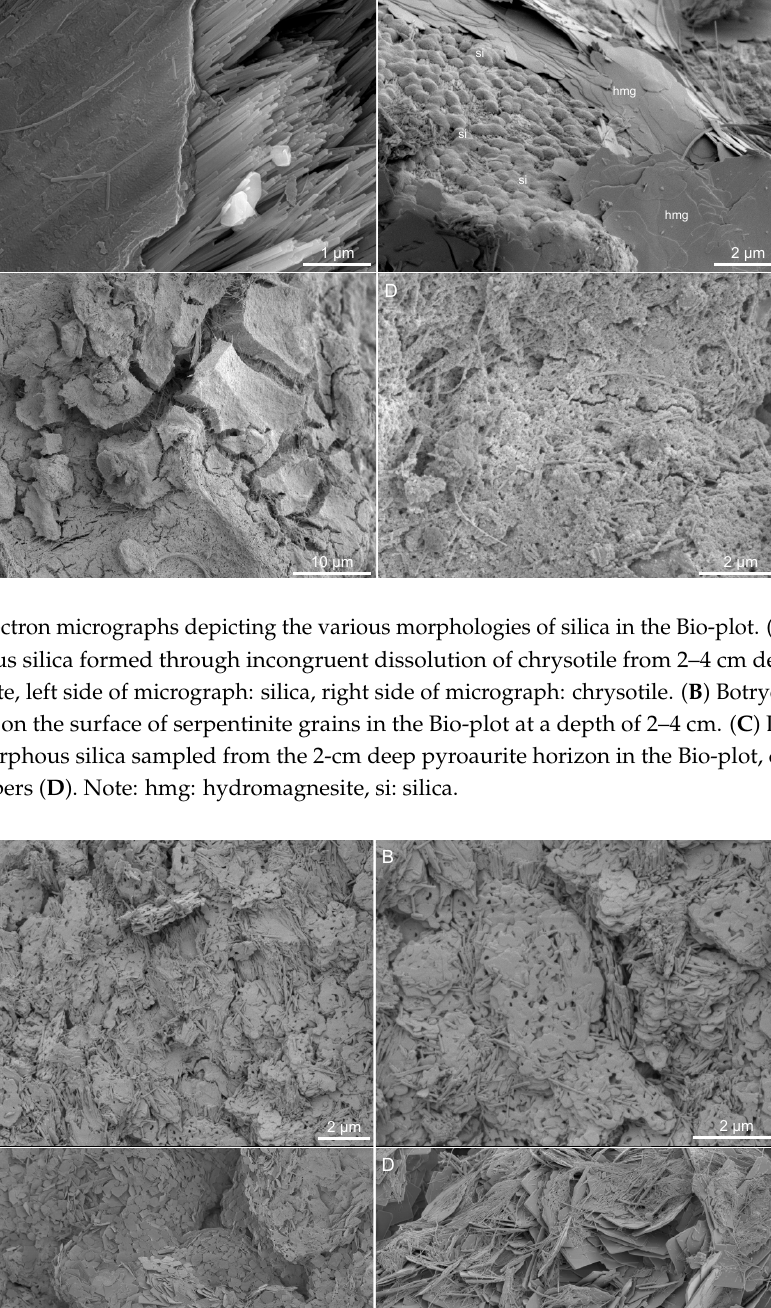
Figure 3. Electron micrographs of a cross-section through the carbonate horizon (2–4 cm depth) in the Bio-plot. ( A ) The hydromagnesite initially formed as meniscus cements at grain contacts. ( B ) Cements can be observed immobilizing bundles of chrysotile fibers. ( C ) In some cases, voids are in-filled with hydromagnesite cement. ( D ) The hydromagnesite cement has immobilized serpentinite grains. ( E ) Cement beginning to form among fibers of chrysotile (arrow). ( F ) Chrysotile fibers (arrow) enclosed in cement forming within a serpentinite grain. Note, hmg: hydromagnesite, serp: serpentinite.